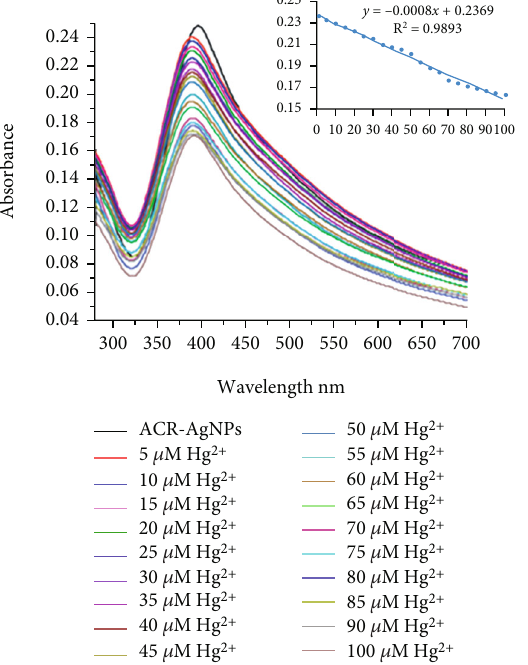
Figure 9: Change in the absorption intensity of ACR-AgNPs upon addition of varied concentrations of Hg 2+ (5-100 μ